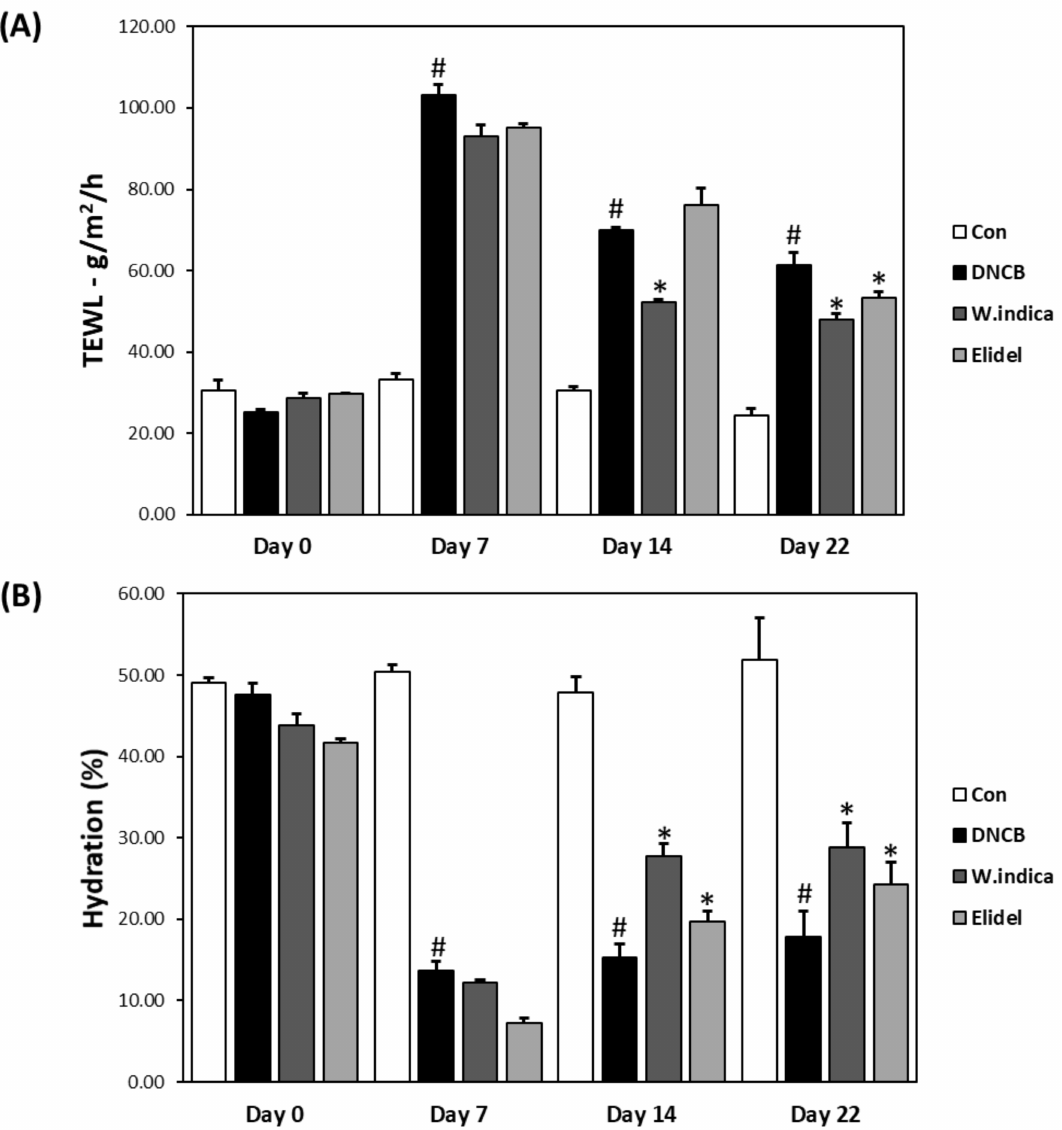
Figure 5. E ff ects of W. indica extract on skin barrier function. ( A ) Transepidermal water loss (TEWL). ( B ) Skin hydration values. Results are expressed as the means ± SEMs (n = 7) of two independent experiments. # p < 0.05 vs. the CON group; * p < 0.05 vs. the DNCB group. CON: vehicle control